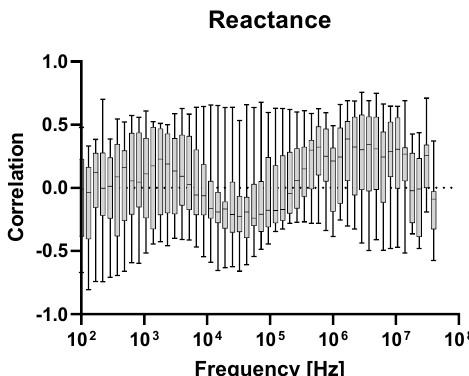
Fig.5: Correlation between measured reactance at different frequencies, and blood glucose level.